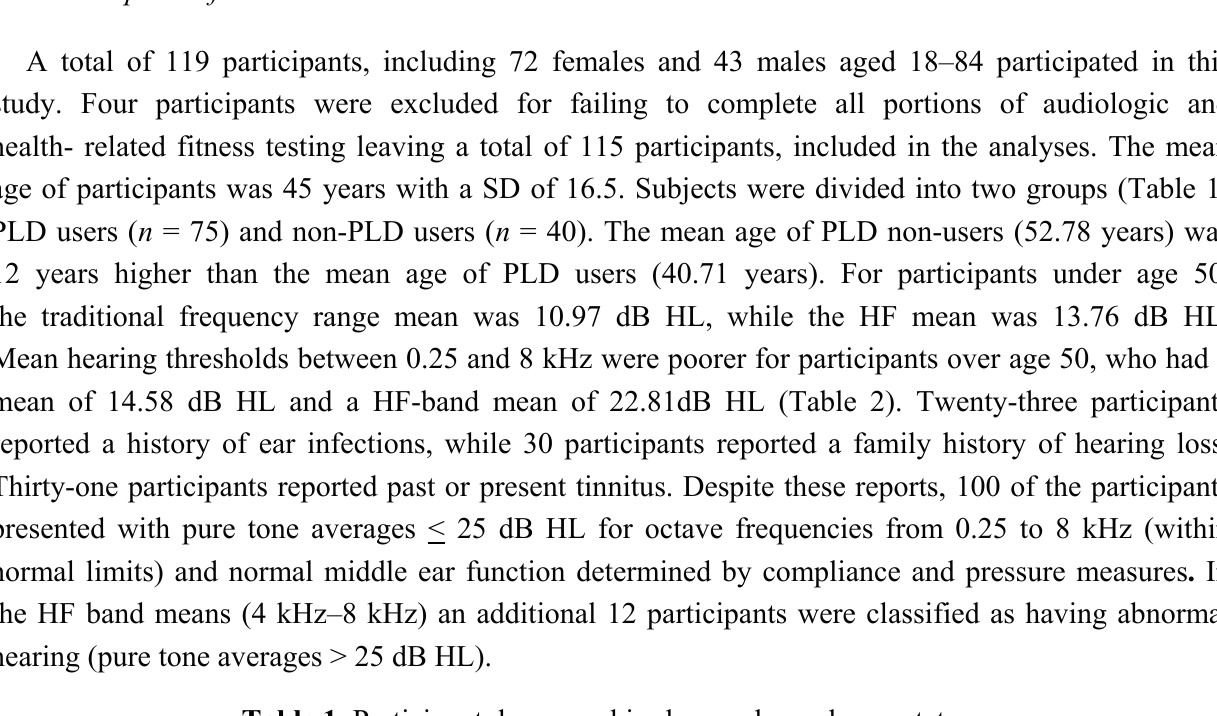
Table 1. Participant demographics by gender and user-status.